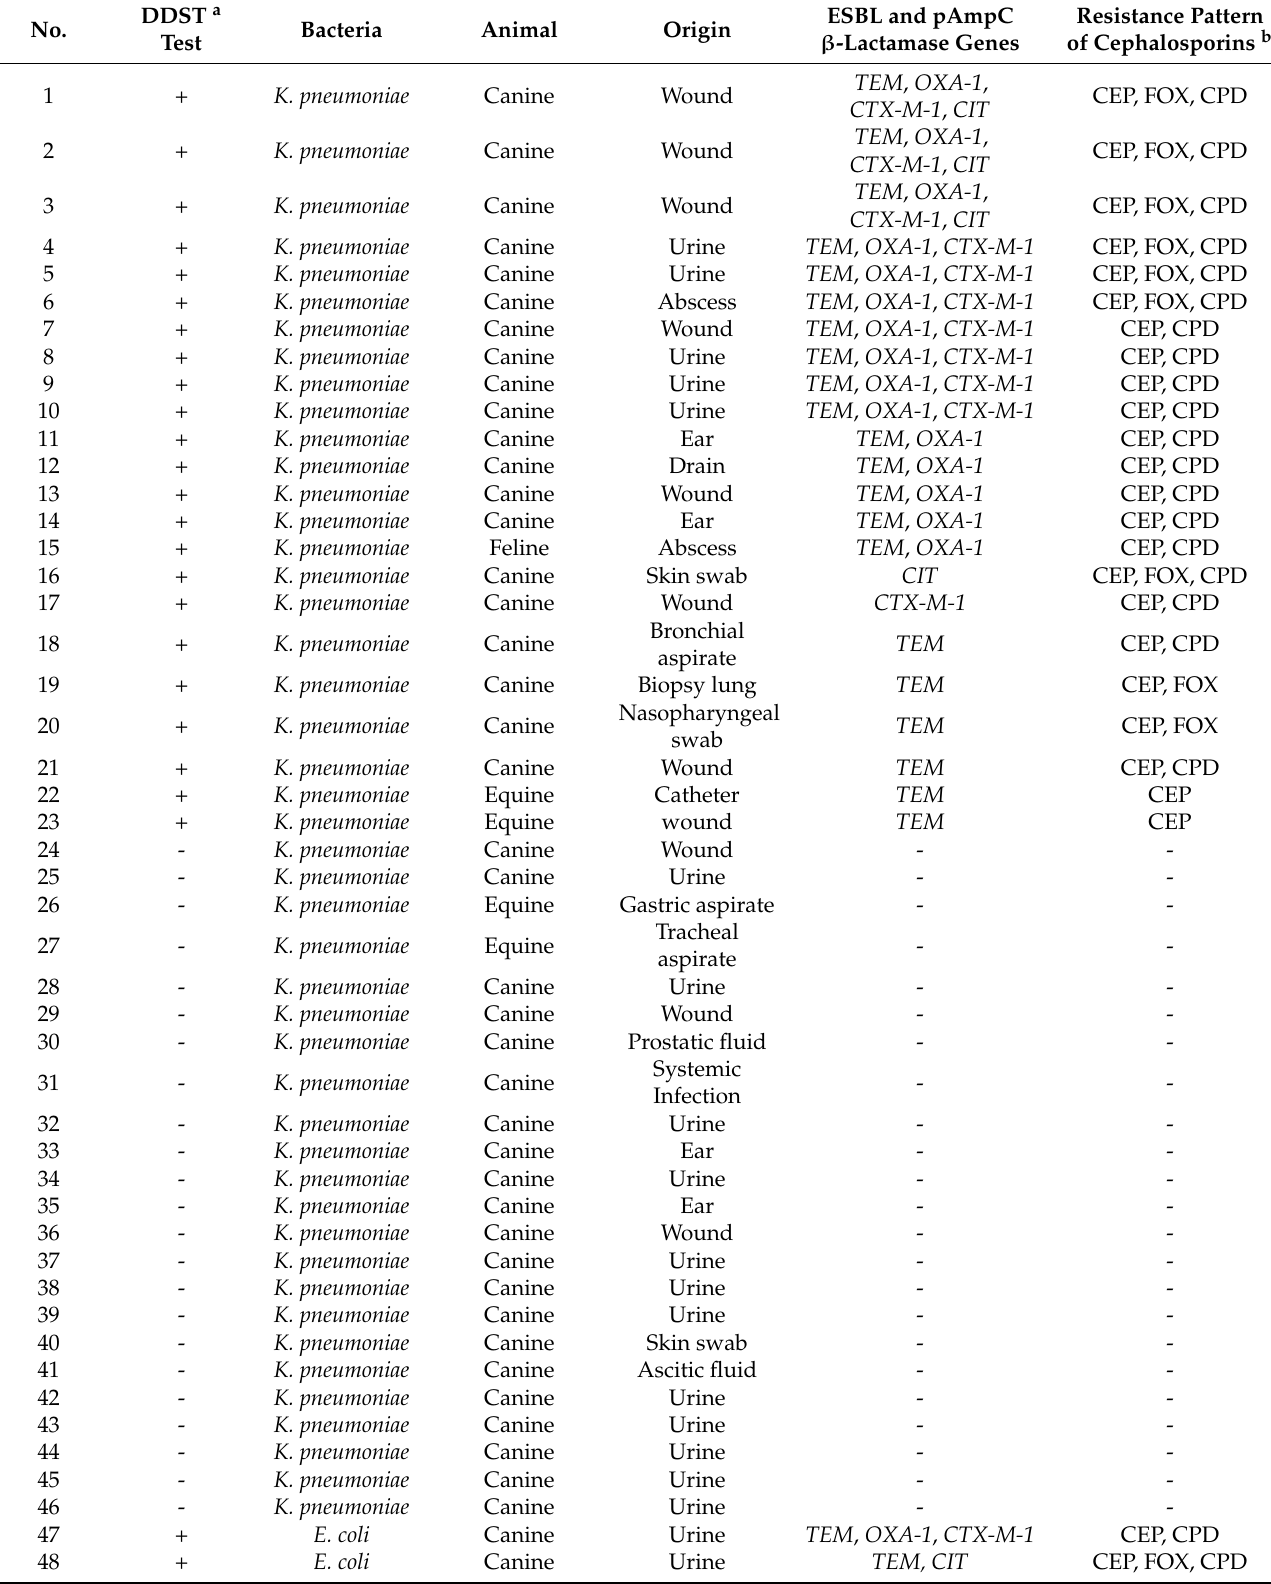
Table 1. History of E. coli and K. pneumoniae used in this study for the development of an isola- tion